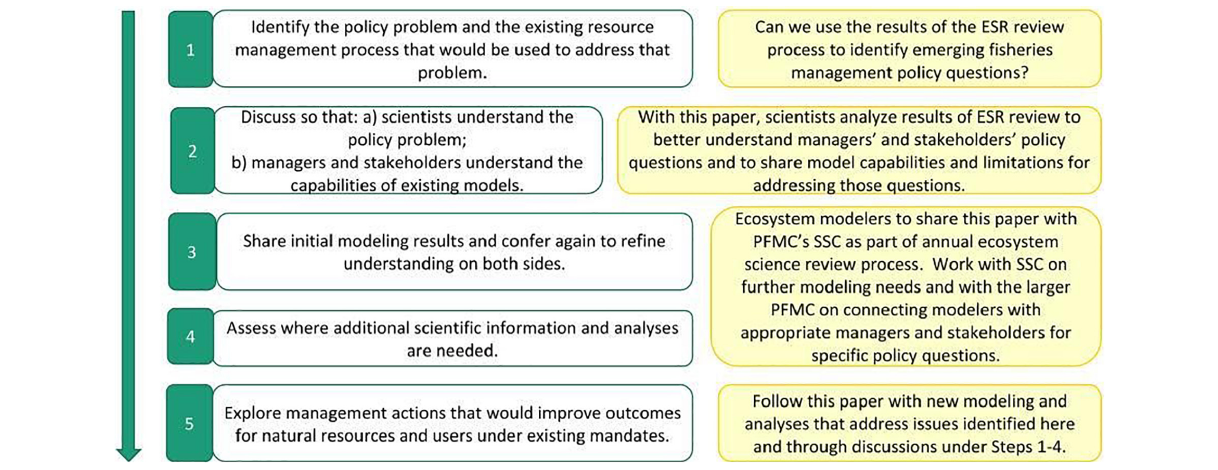
Frontiers in Marine Science |